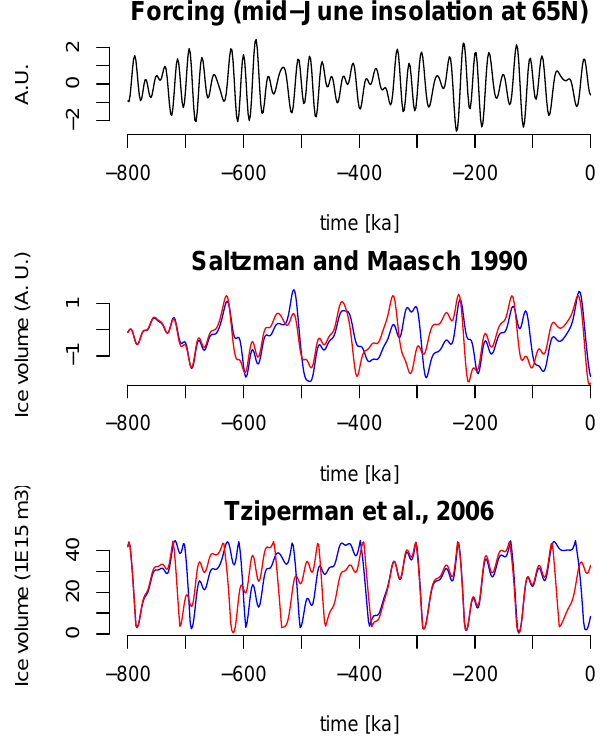
Fig. 1. Ice volume simulated with two models previously published: Saltzman and Maasch (1990) and Tziperman et al. (2006), forced by normalised insolation at 65 ◦ N. The blue lines are obtained with the published parameters; the latter were slightly changed to obtain the red ones: p 0 = 0 . 262Sv instead of 0.260Sv in Tziperman et al. (2006), and w = 0 . 6 instead of w = 0 . 5 in Saltzman and Maasch (1990). While the qualitative aspect of the curves are preserved, the timing of ice ages is affected by the parameter